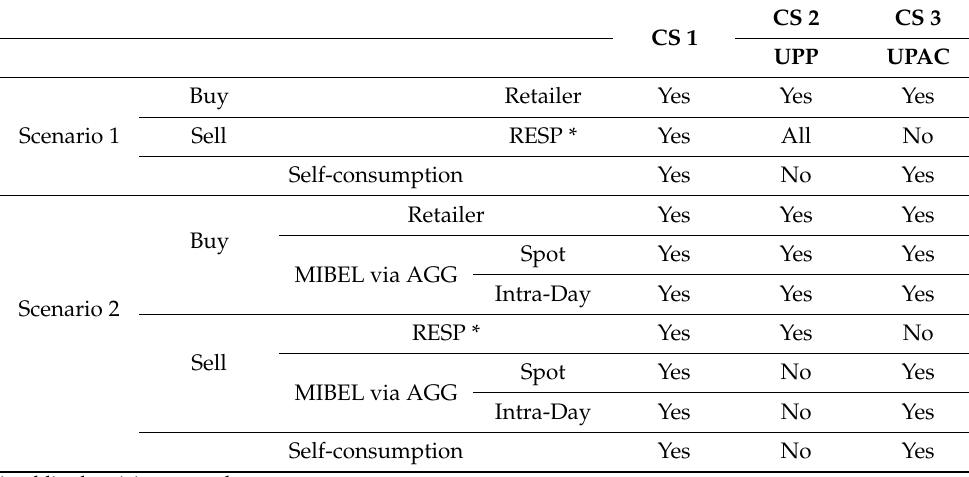
Table 1. Case study conditions